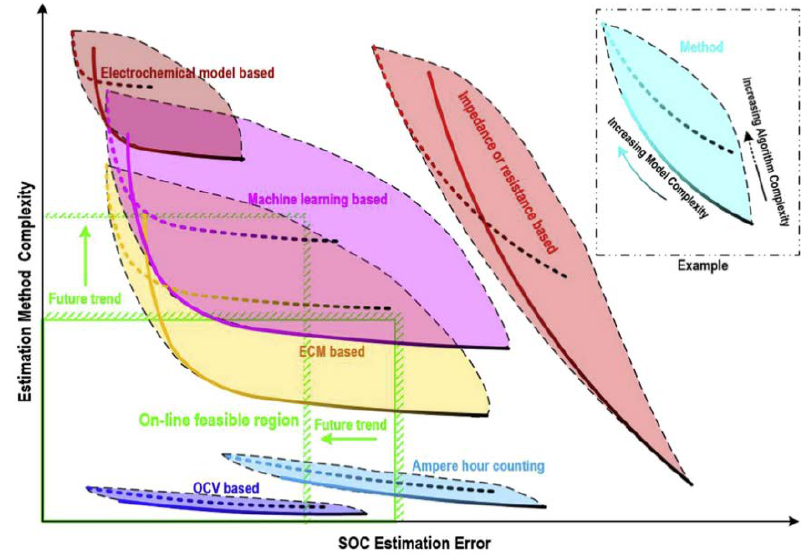
Figure 17. Estimation error and computational complexity for the commonly studied SOC estimation methods [83].